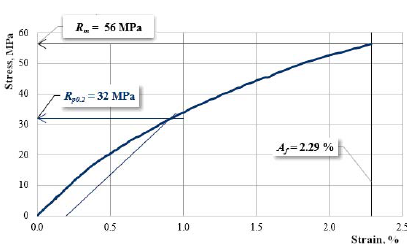
Figure 5. The characteristic curve for a sample